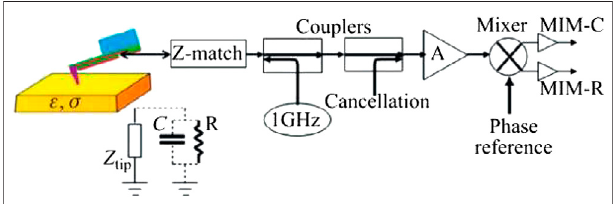
FIGURE 4 | Depiction of the experimental set up for sMIM. [30] Reproduced withpermission from Appl.Nanosci. 1,1(2011). Copyright2011 Springer Nature.